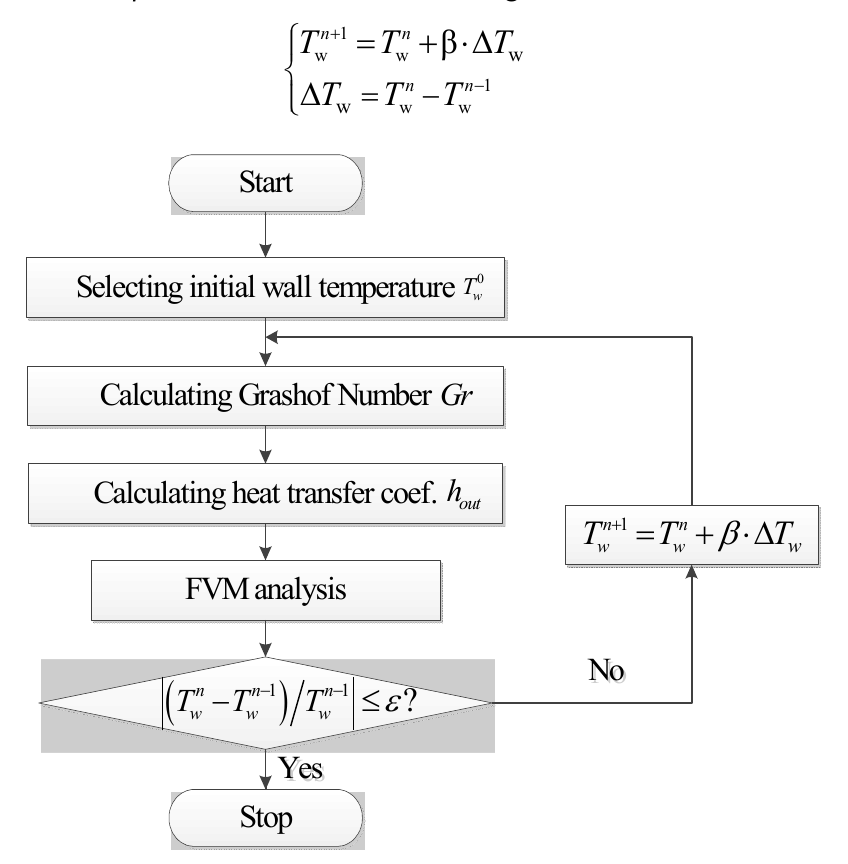
Figure 8. Flow diagram of the iterative